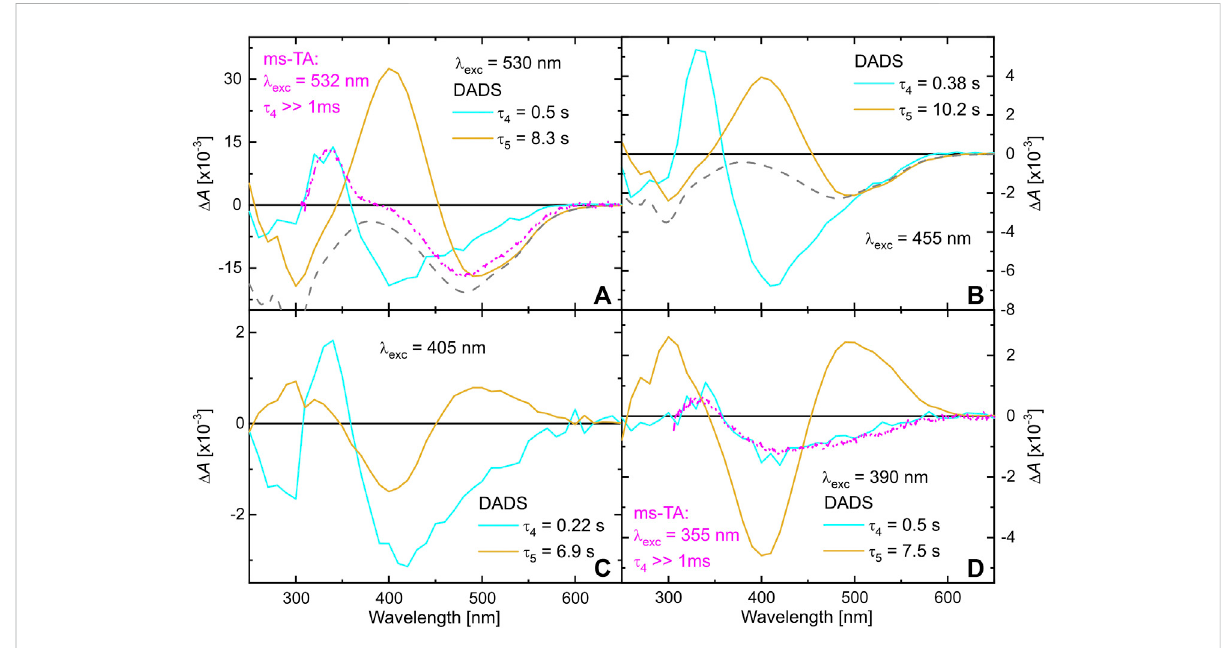
FIGURE 5 DADS of TPF dissolved in methanol, obtained by a global biexponential fi t to the data matrices detected after excitation at 530 nm (A) , 455 nm (B) , 405 nm (C) and 390 nm (D) . The gray-dashed line represents the absorption spectrum of the solution, while the pink DADS are taken from Figure 4 for